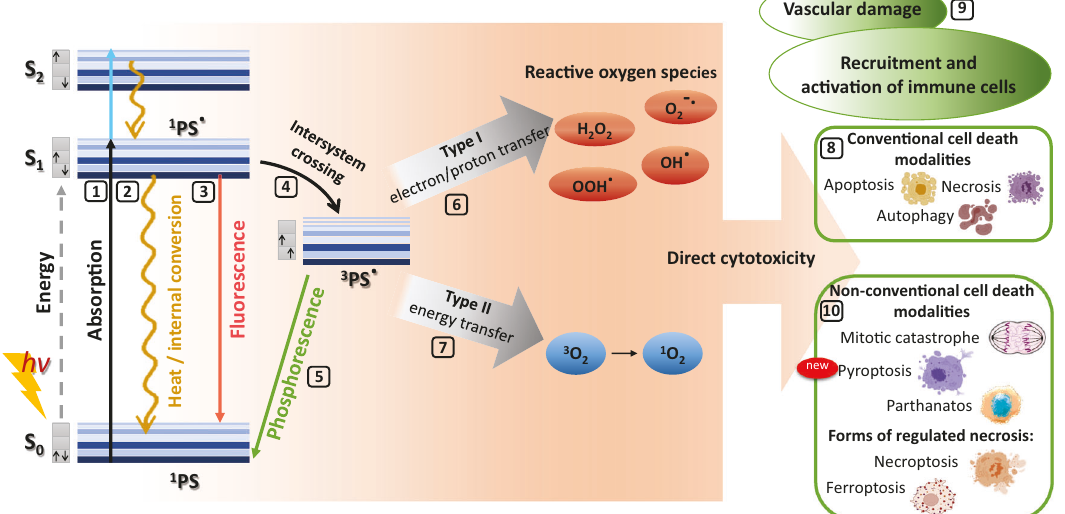
Fig. 1 Mechanisms of photodynamic reactions and biological effects induced by photodynamic therapy. The photosensitizer (PS) accumulates in cancer cells, absorbs photons ( hv ) from a light source of appropriate wavelength, and is transformed to the short-lived excited singlet state ( 1 PS (cid:129) ) [1] [11]. 1 PS (cid:129) can lose its energy by internal conversion into heat [2] or by emitting light ( fl uorescence) [3]. 1 PS (cid:129) could also be transformed into a long-lived excited triplet state ( 3 PS (cid:129) ) via an intersystem crossing process [4]. Besides the ability of reversion to a singlet